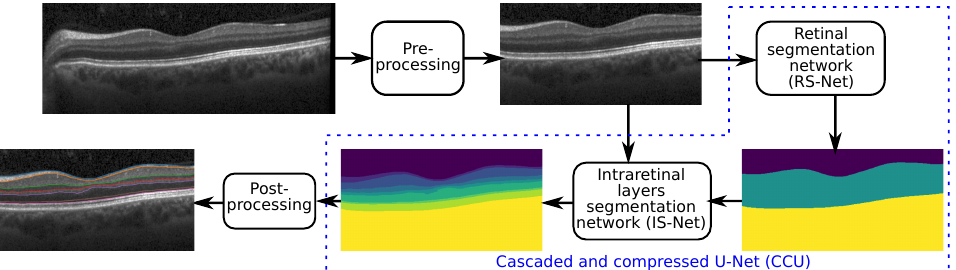
Figure 1. The pipeline of the proposed method consists of four steps: preprocessing, retinal region segmentation, intraretinal layer segmentation, and